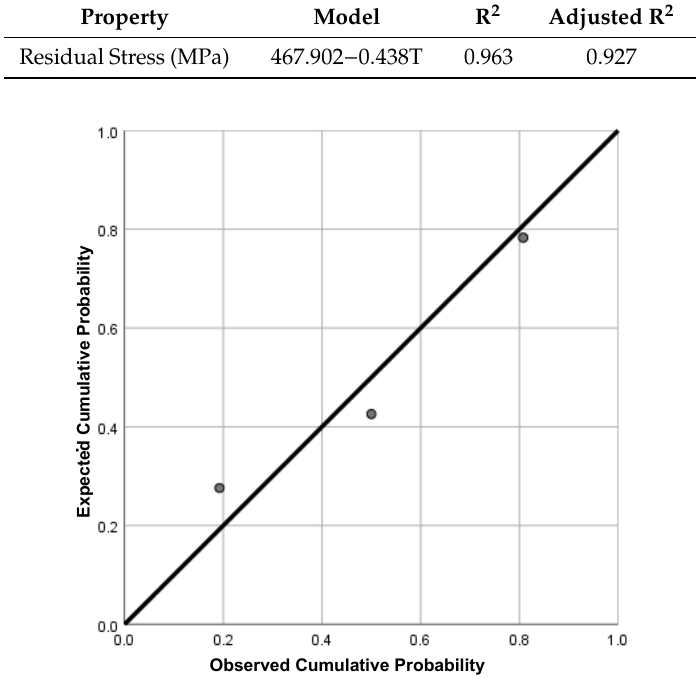
Figure 4. Normal probability plot for residual stress of ferritic stainless steel.